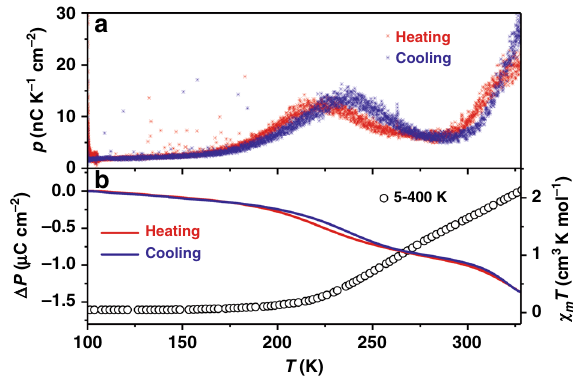
Fig. 4 Pyroelectric properties and polarization change between 100 and 330 K. a Pyroelectric coef fi cient ( p , red and blue stars) on a single crystal of 1 ·0.5EtOH between 100 and 330 K with a sweep rate of 5 K min − 1 ; b polarization change ( Δ P , red and blue lines) as comparison with the χ m T products (open